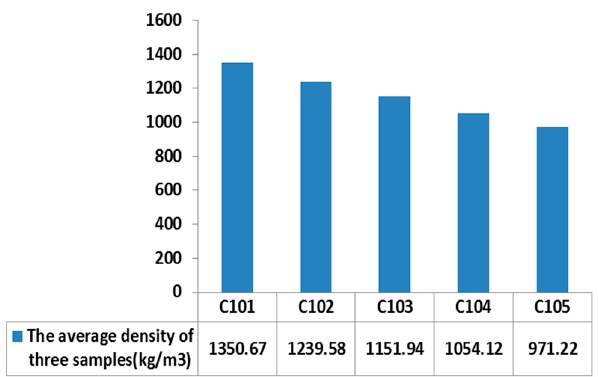
Figure 11. The test results of density (kg/m 3 ).